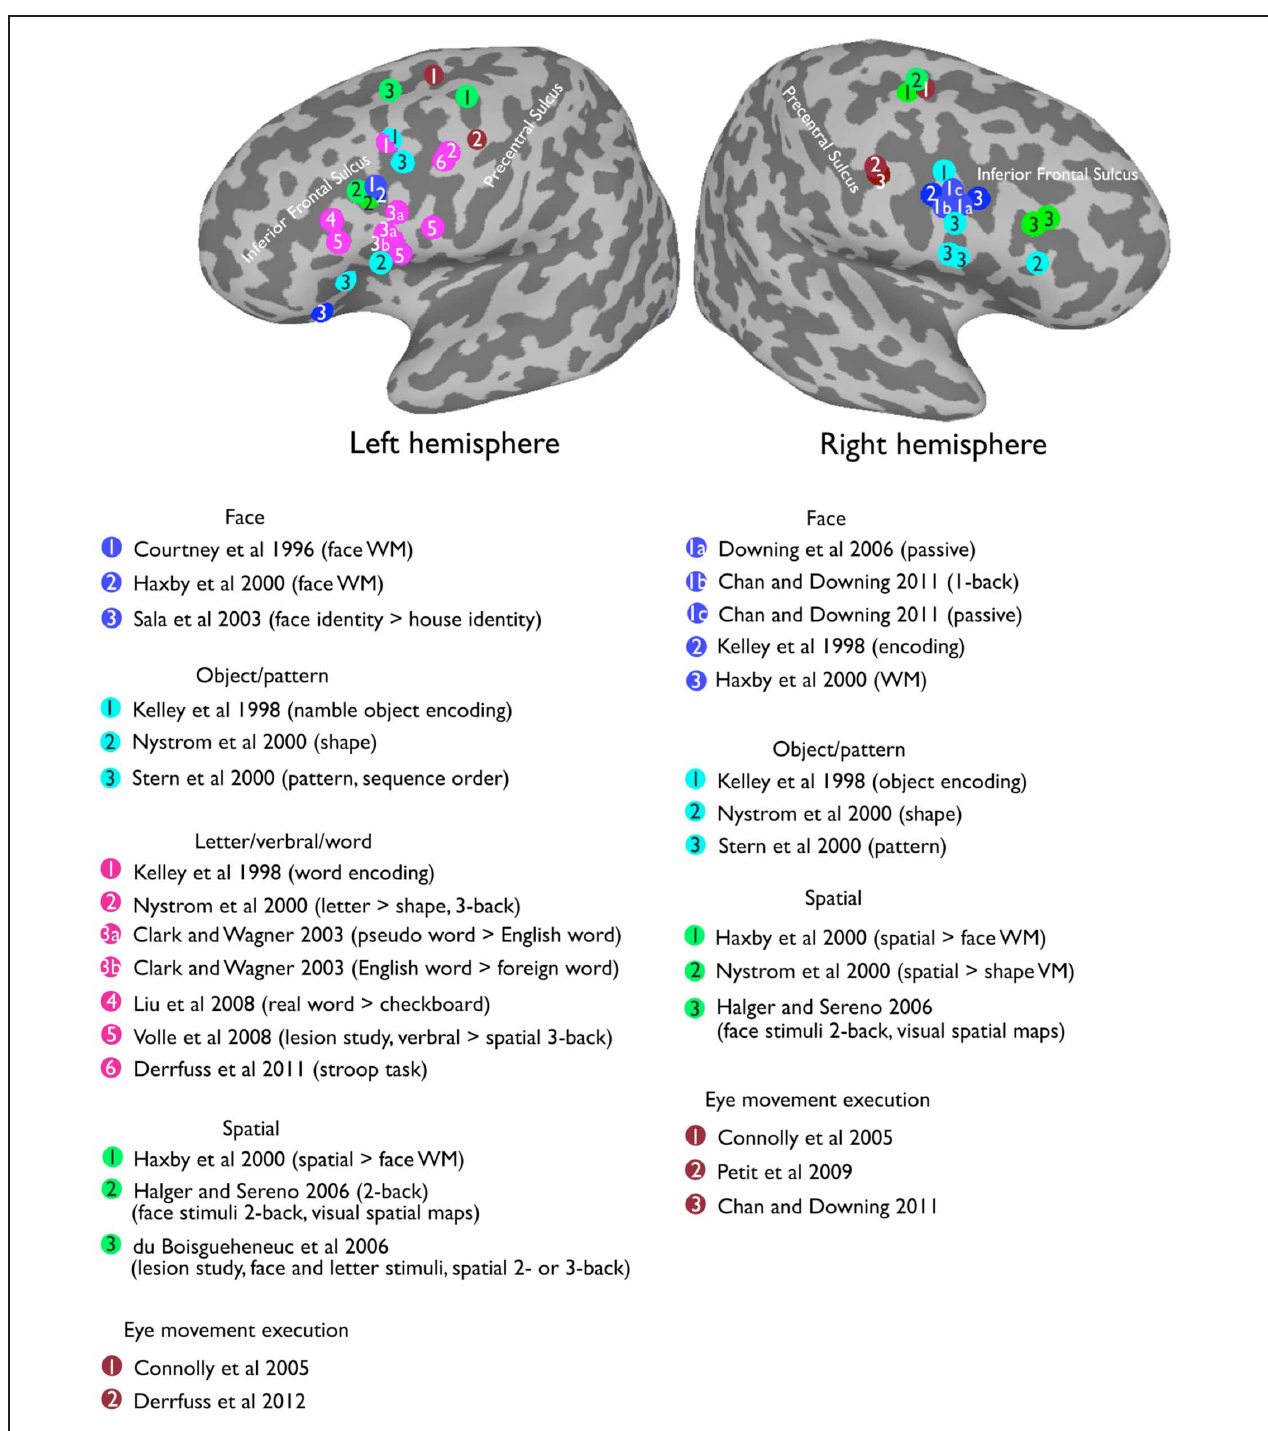
FIGURE 5 | Reported peak activations from a selection of prior studies in the lateral prefrontal cortex overlapping on a standard MNI inflated